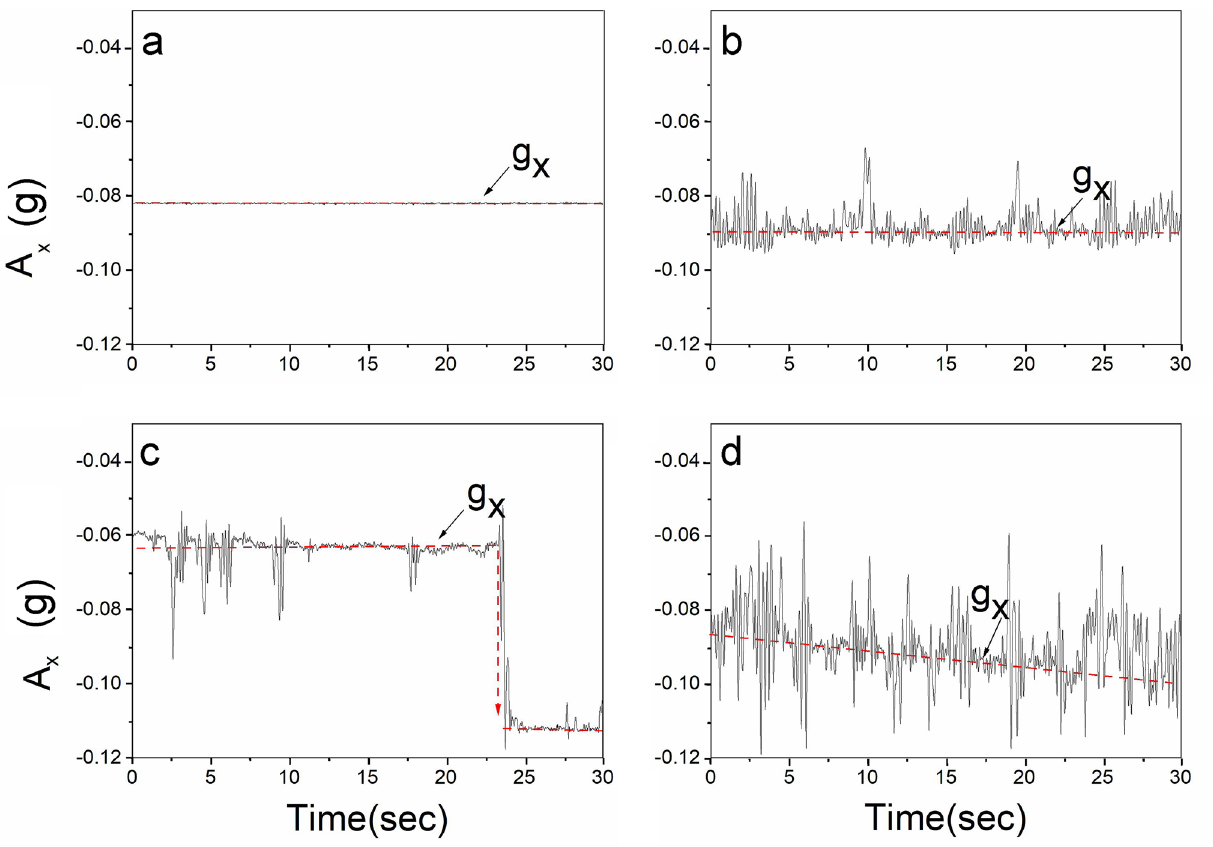
Figure2. Representative time series of A x (The vibration signal output by the sensor), The dotted line shows the acceleration due to gravity (g x ), The four pictures represent different working conditions: ( a ) stationary state (v = 31 cm/s), ( b ) grain vibration (v = 34 cm/s), ( c ) sediment rolling (v = 44 cm/s), ( d ) sediment pushing (v = 44